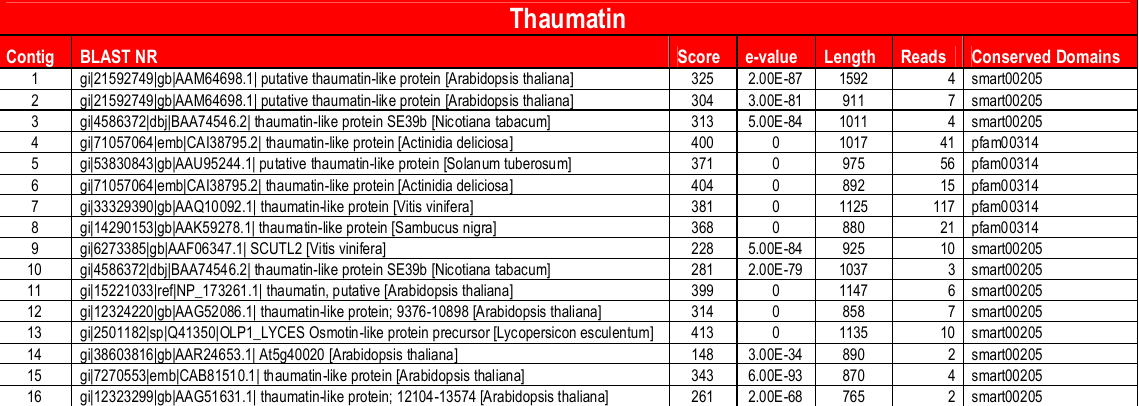
Table S9: EST-Contigs with e-value < e -20 and score > 100 obtained in the Project Thaumatin, and their blast hit, score, e-value, size, number of reads, and conserved domains from putative